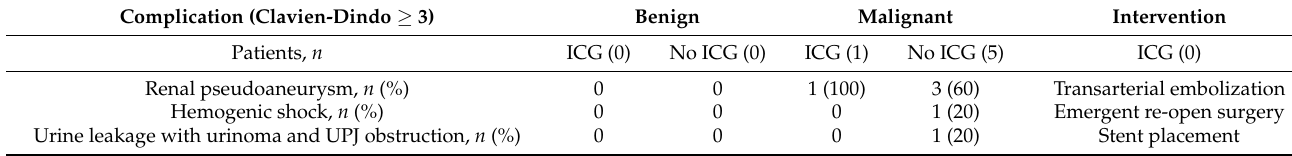
Table 4. High-grade complications and subsequent